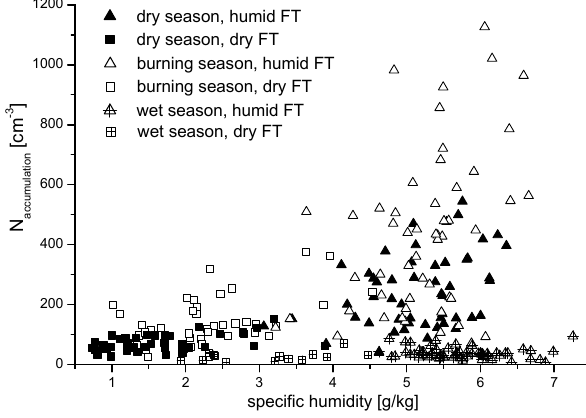
Fig. 5. Relation between specific humidity and the number concen- tration of accumulation mode